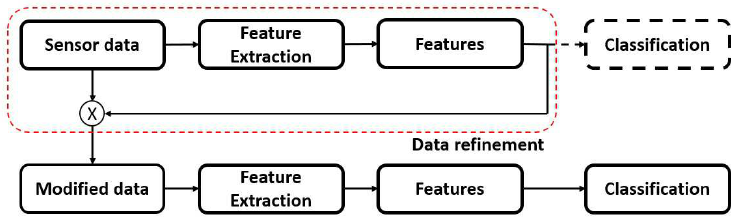
Figure 1. Concept of using feature feedback as a data-refinement method in a classification system.